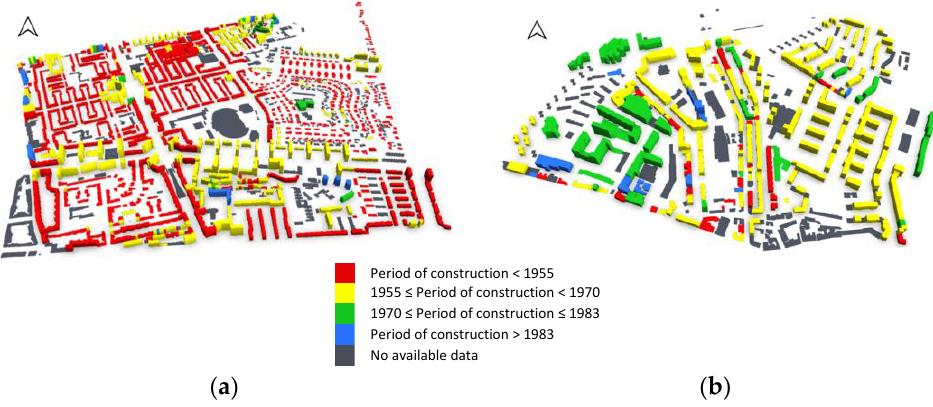
Figure 13. Period of construction thematic map of ( a ) Alvalade and ( b ) Benfica.